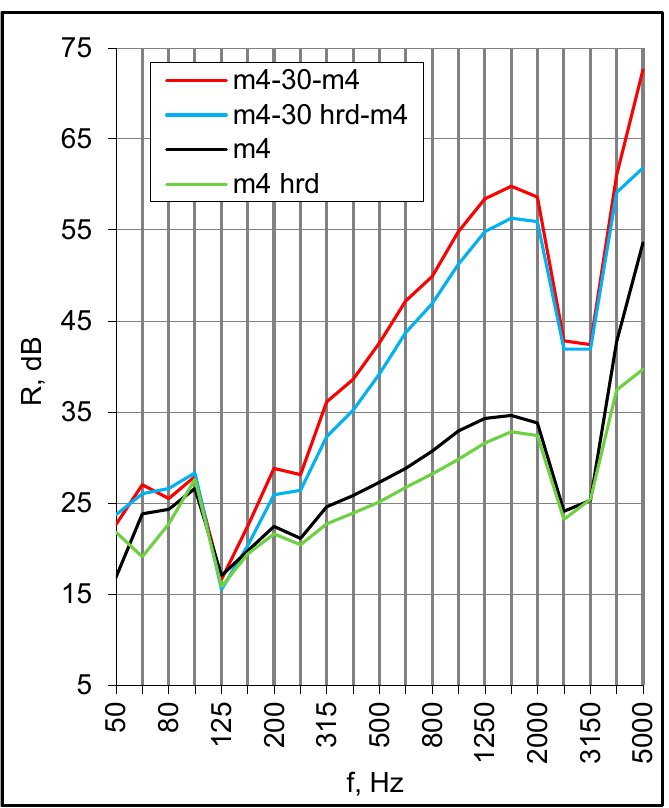
Figure 10. The effect of the panel edges support hardening (hrd) on the sound insulation.